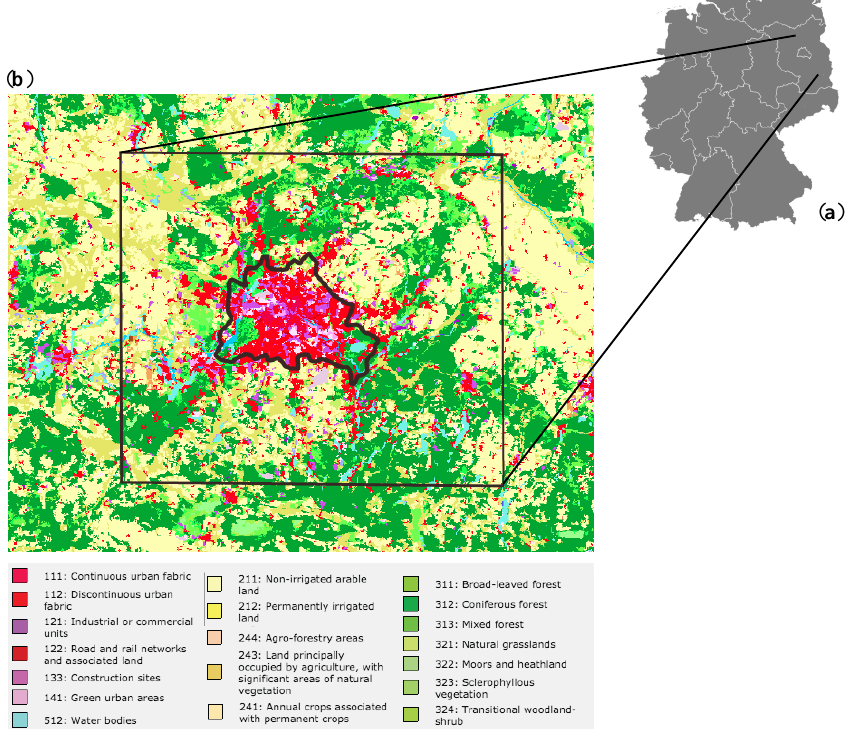
Figure 1. Research area. ( a ) Germany and ( b ) a land-cover map indicating Berlin’s administrative boundaries (black polygon) and research domain including its surroundings (black rectangle). Land cover follows the CORINE land cover map [42].